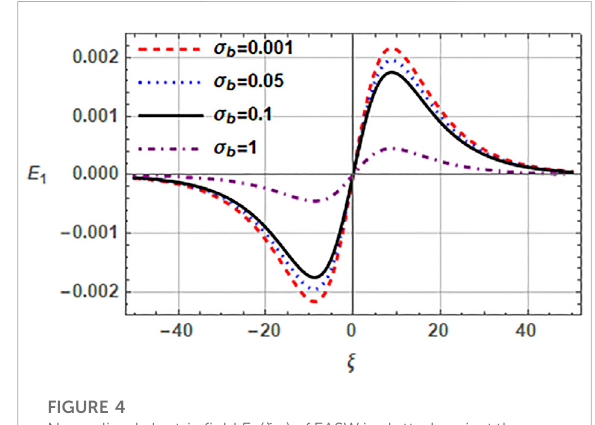
FIGURE 4 Normalizedelectric fi eld E 1 ( ξ , τ )ofEASWisplottedagainstthe normalized ξ by varying the beam to hot electron temperature ratio σ b with q = 2.5, r = 0.4, n c 0 = 0.5 cm − 3 , n h 0 = 2 cm − 3 , n b 0 = 1 cm − 3 , σ c = 0.001, v b 0 = 0.1 and τ =